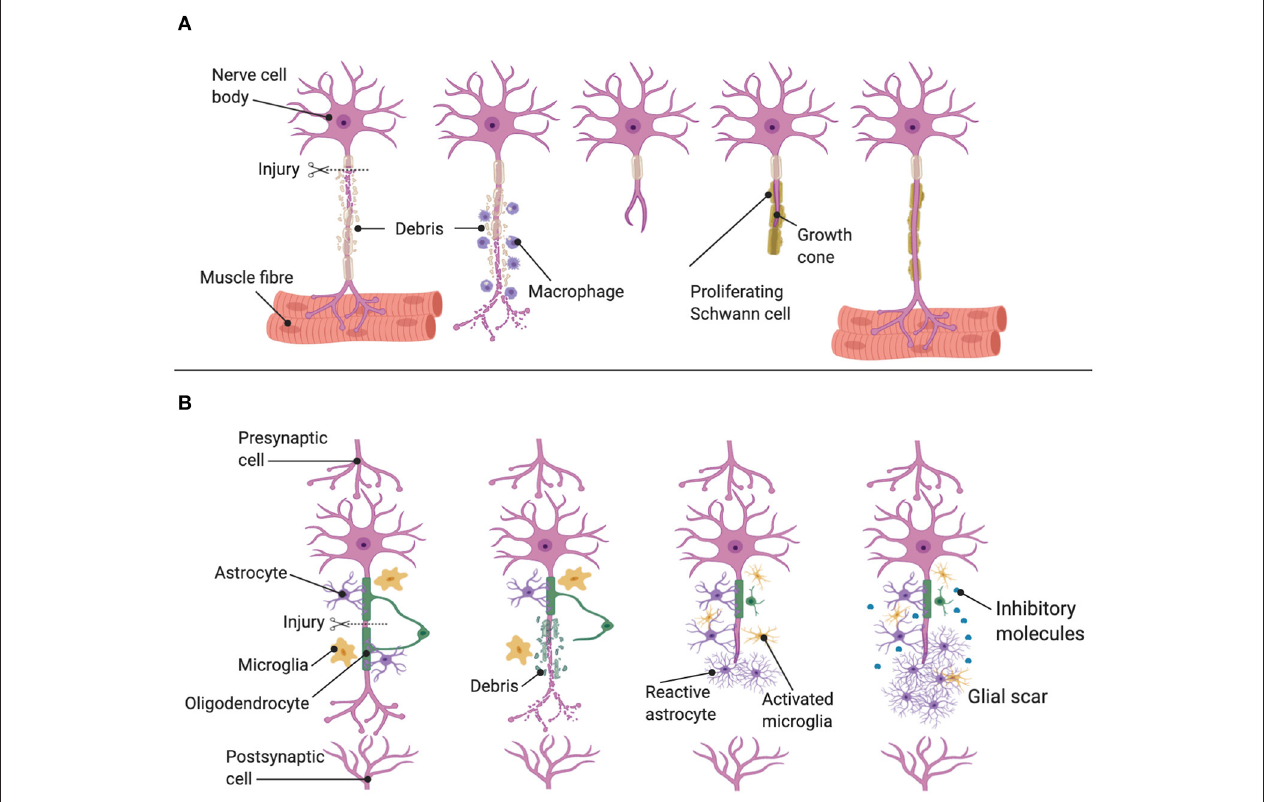
FIGURE 4 | Regeneration mechanisms after injuries. (A) Regenerative situation in PNS. Proliferating SC and macrophages work together to remove myelin debris, release neurotrophins, and lead axons toward their synaptic targets, resulting in restored neuronal function. (B) Regenerative situation in CNS. The few neurons that survive axotomy attempt regeneration and subsequently meet an impenetrable glial scar composed myelin and cellular debris, as well as astrocytes, oligodendrocytes, and